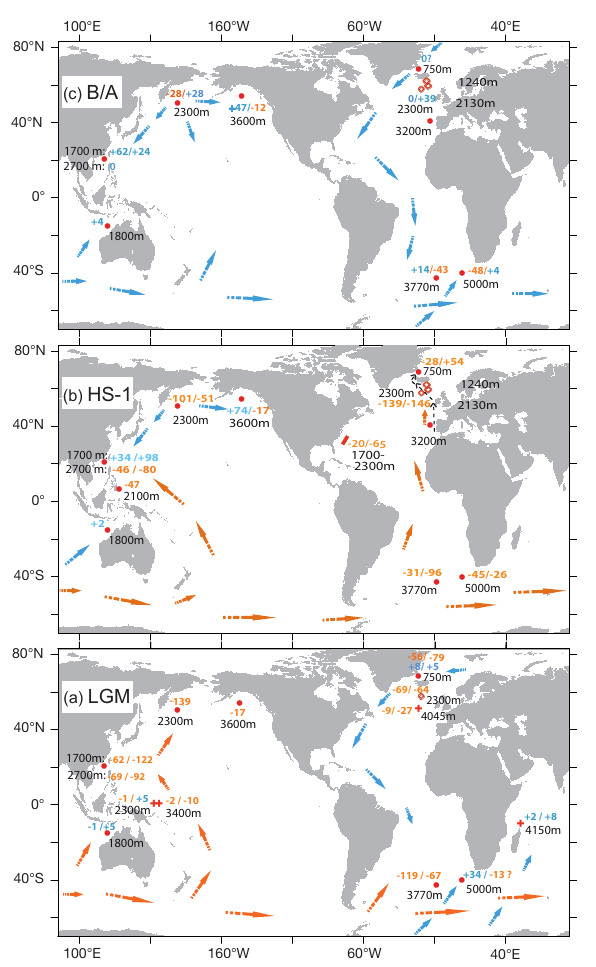
Fig. 6. Past shifts in carbonate ion concentrations and tentative sim- plified circulation patterns below 1500mw.d. (see caption of Fig. 7) for the B/A, HS-1, and LGM. Core locations and data sources are listed in Table 1. For the LGM we include [CO − 2 ] data derived by 3 Yu et al. (2010) from B–Ca ratios (locations marked by + signs), which by and large corroborate our rough 1 14 C-based [CO − 2 ] pat- 3 tern. Orange values and arrows mark concentrations higher than to- day, blue values and arrows present concentrations equal or lower than today (Fig. 1). Question marks earmark age estimates based on disputable dating techniques and/or indirect evidence (Table 1b and Supplement #8). Arrows are not based on real data, but on highly simplified inferences per analogy to those in Fig. 7. Hatched black arrows mark potential current of intermediate waters during HS-1. Red diamonds in the northeastern North Atlantic mark three sites with a composite 1 14 C record (Thornalley et al.,